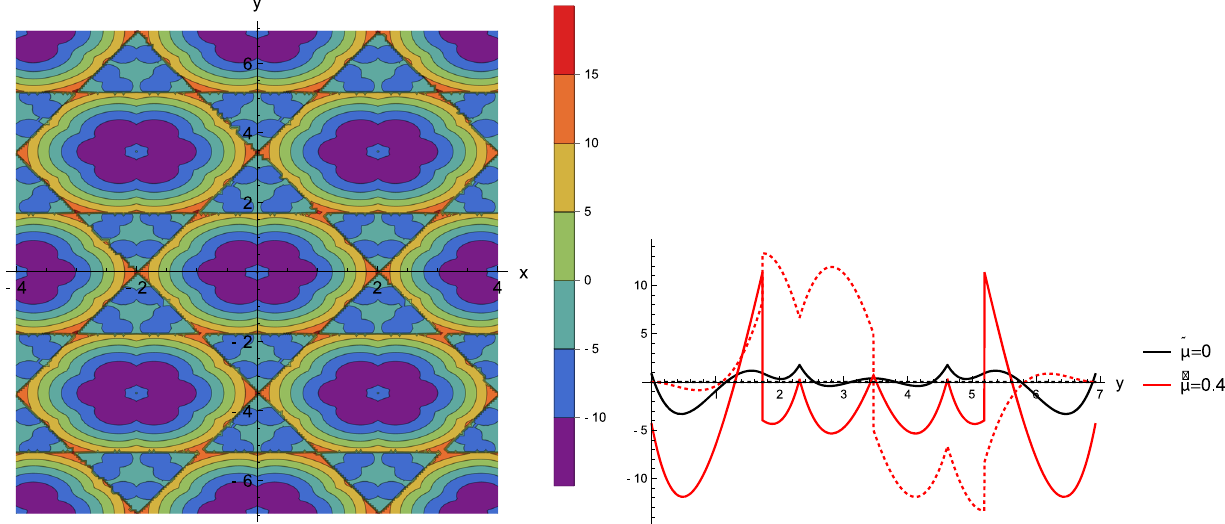
˜ μ = 0 and ˜ μ > 0. The jumps result from the product of the odd-number polynomials in (16). The dotted line is the imaginary part present for ˜ μ = 0 . 4